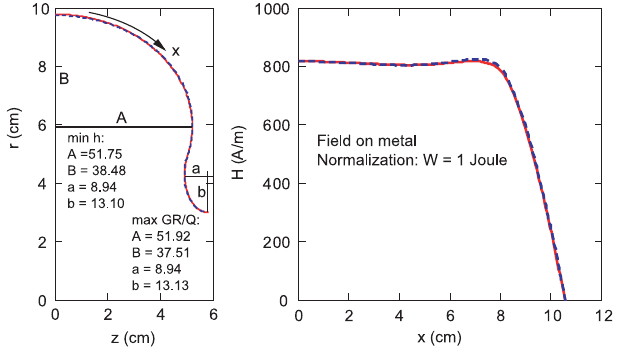
FIG. 5. (Color) Geometries of the cells (left picture) with min h (red solid line) and max G (cid:1) R sh =Q (blue dashed line) practically coincide. Difference in magnetic fields along the profile lines of the cell (right) is also negligible. A , B , a , and b are half-axes of elliptic